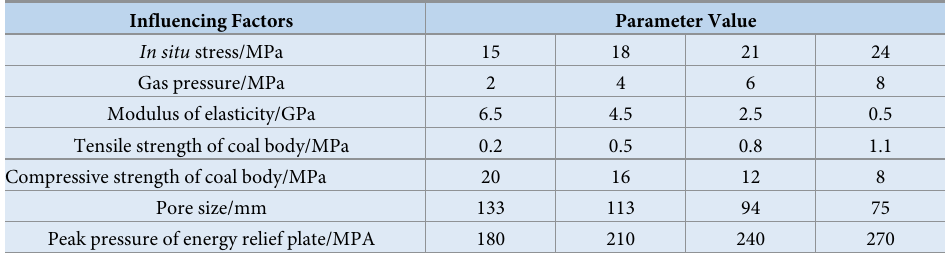
Table 3. Parameter values of each